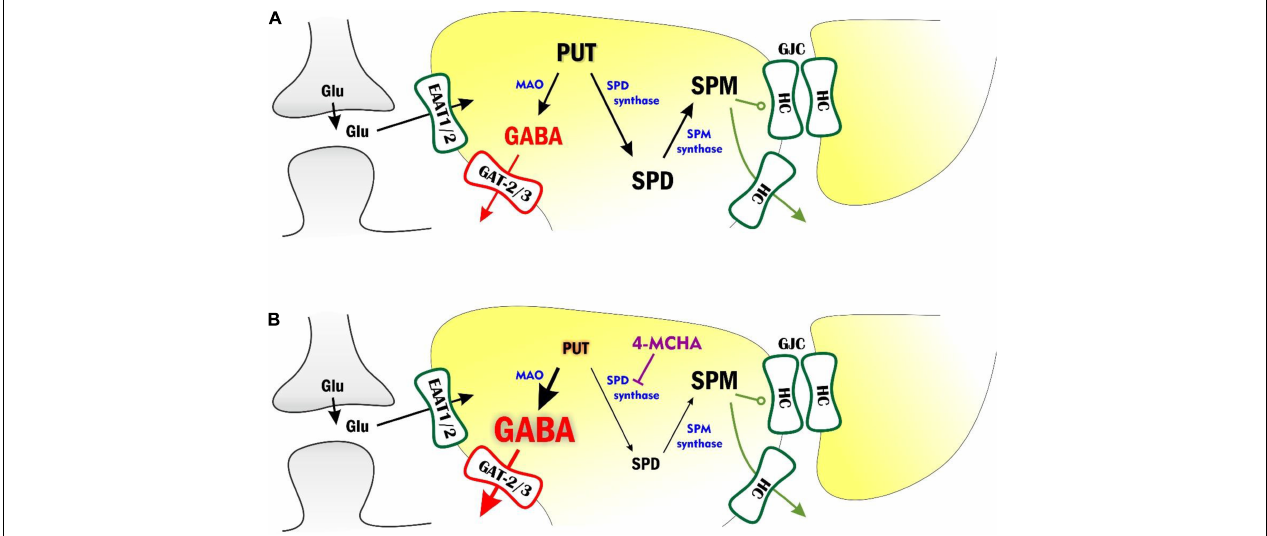
FIGURE 6 | Modulation of polyamine metabolism and astrocytic GABA pathway can attenuate epileptiform activity through multiple pathways. (A) Astrocytic polyamine metabolism affects network excitation by multitude of ways. Putrescine (PUT) can be converted to GABA by monoamino oxidases (MAO). The astrocytic GABA is subsequently released by the reverse operation of GAT-2/3 transporters and increases tonic inhibition on neurons. PUT can also be metabolized to spermidine (SPD) and spermine (SPM). SPM, on the other hand, keeps open astrocytic gap junctions, formed from connexin hemichannels (HCs) and can also release and facilitate neuronal activity. (B) Inhibition of SPD synthase would increase astrocytic PUT concentration. However, according to measurements of extracellular polyamine levels ( Figure 4 ), PUT is converted to GABA, which is released into the extracellular space (denoted by larger font sizes). SPD synthase inhibition also reduces SPD concentration (denoted by smaller font size). Levetiracetam, on the other hand, can increase the surface expression of GAT-2/3 transporters through which astrocytic GABA is released from astrocytes, generating larger tonic